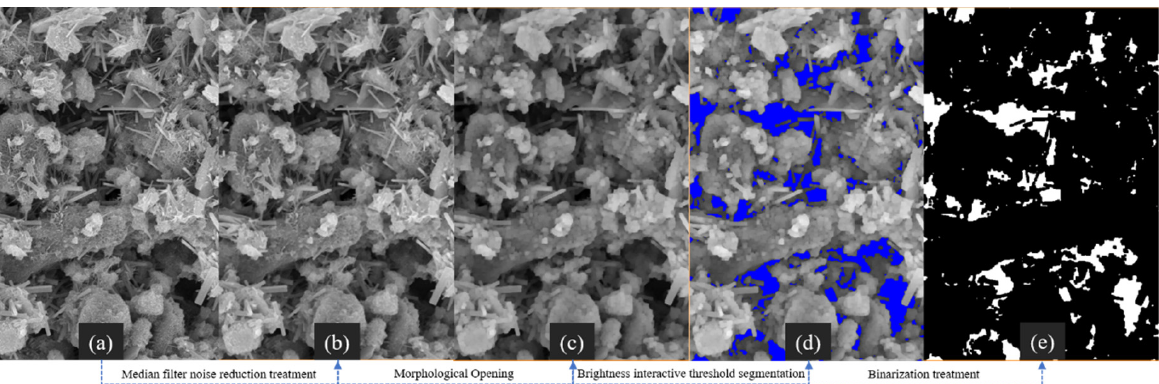
Figure 6. The treatment process of SEM image; ( a ) the original SEM image, ( b ) median filter noise Figure 5. SEM image of LMPGCB of group B; ( a ) ×5000 magnification, ( b ) ×2000 magnification, and reduction image, ( c ) morphological opening image, ( d ) the brightness interactive threshold segmen- ( c ) binarization image. tation image, and ( e ) binarization image.